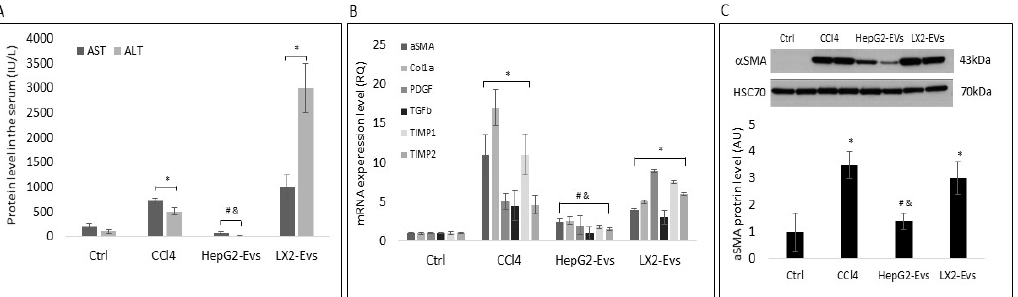
Figure 5. The effect of LX2 and HepG2 Extracellular Vesicles on liver fibrosis markers in-vivo. Eight- week-old male C57BL6 Mice were injected with 2 mL/kg CCl4 twice a week for 4 weeks. After the last CCl4 injection, EVs from LX2 and HepG2 cell lines (1.5 × 10 9 particles) were IV administered to mice. CCl4 was injected for 2 additional weeks. At the end of the experiment, mice were sacrificed, livers were isolated, and mRNA and protein were extracted. ( A ) The effect of EVs on liver enzyme in CCl4 toxin model. ( B ) The effect of EVs on HSC differentiation markers in CCl4 toxin-induced fibrosis model. ( C ) The effect of EVs on α SMA protein level in CCl4 toxin-induced fibrosis model. # Significantly lower than CCl4, p < 0.05; & Significantly lower than LX2-Evs, p < 0.05; * Significantly higher than Ctrl, p < 0.05 (ANOVA with a post-hoc Bonferroni-adjusted Student’s t -test).